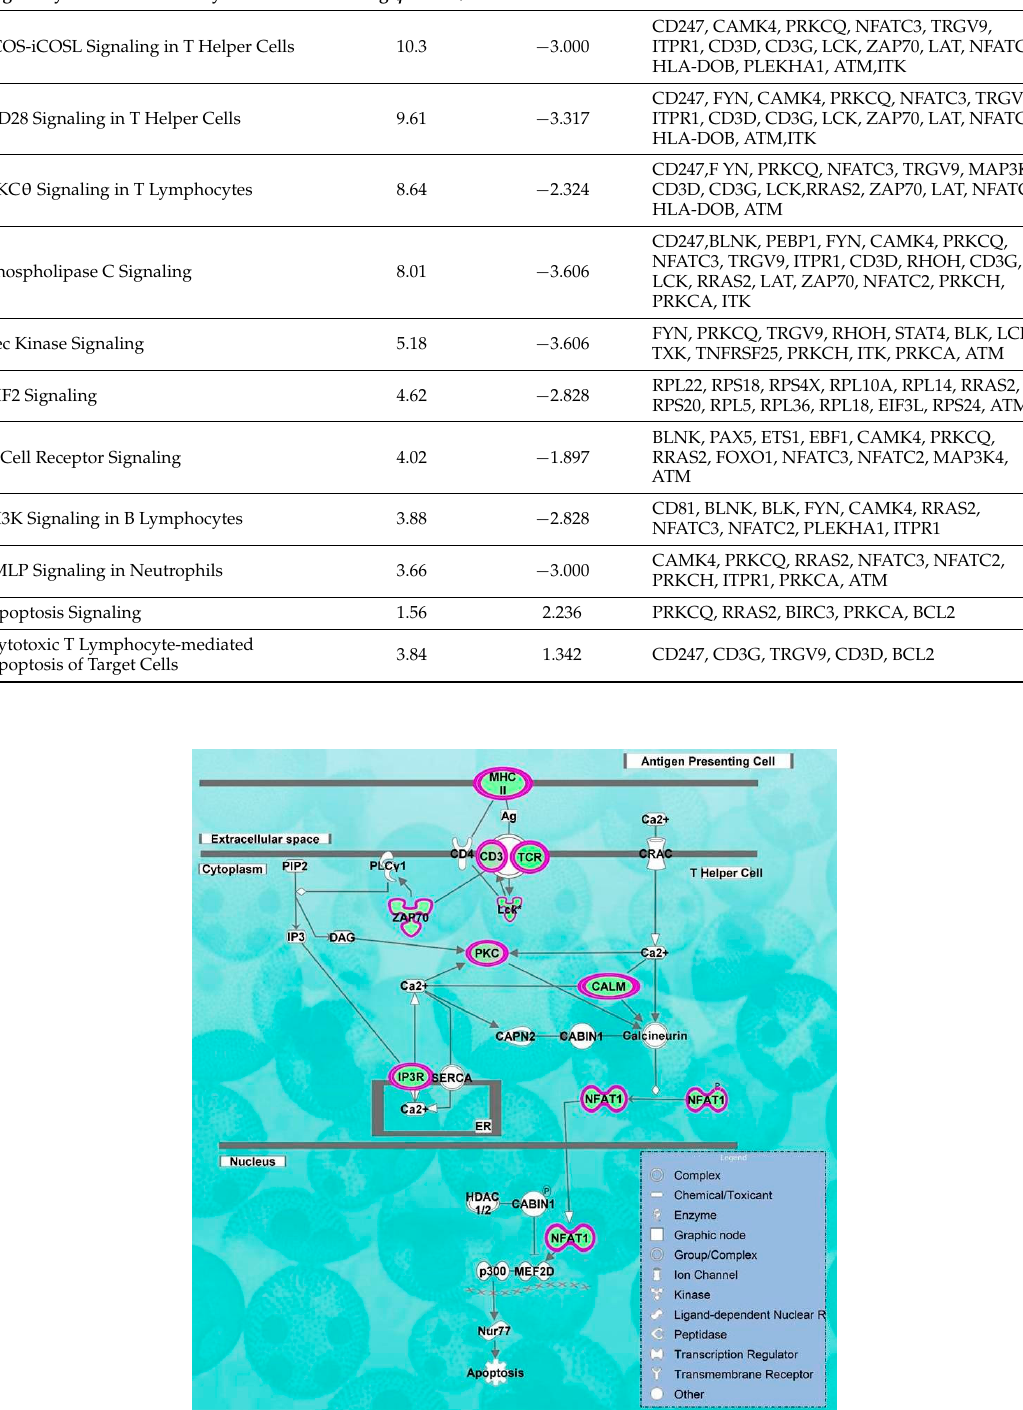
Figure 2. Inhibition of Calcium-induced T Lymphocyte Apoptosis pathway. Based on overlap of identified DEGs to Calcium-induced T Lymphocyte Apoptosis pathways, IPA had predicted its inhibition. CD3 , CAMK4 , TRGV9 , NFAT , ZAP70 , LCK , PRKC , HLA-DOB , ITPR1 genes involved in this pathway were downregulated as shown by the purple circles. XXXX line indicate DNA strand. The white end arrow means “translocation” and the dark end arrow means “acts on”.